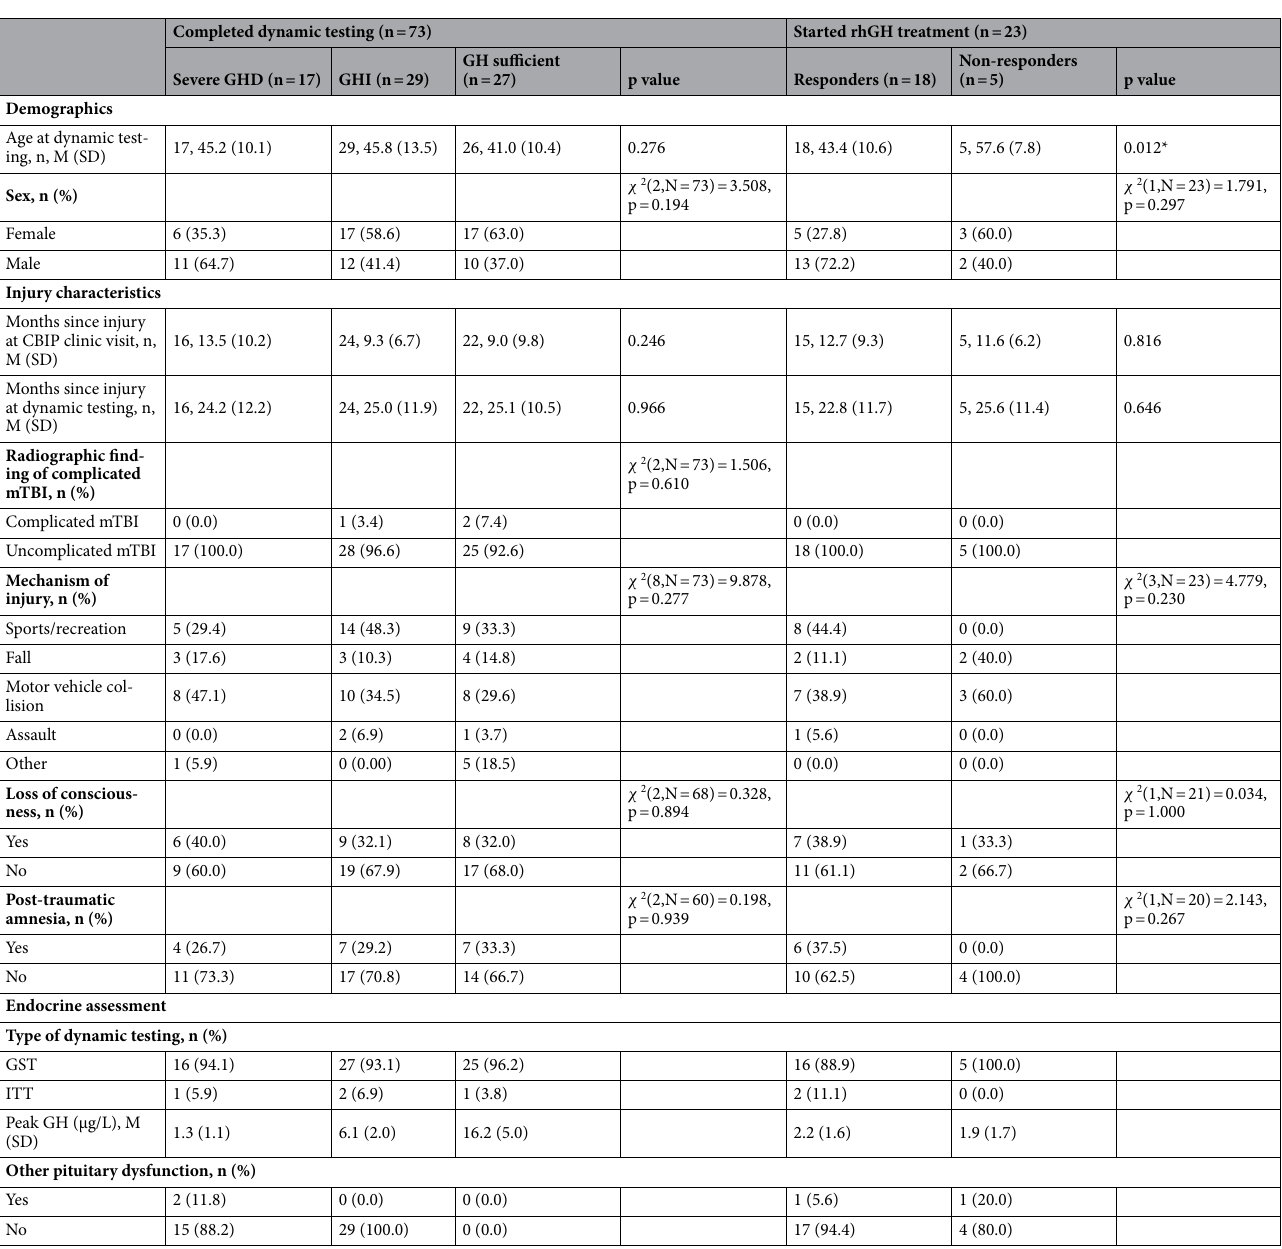
Table 2. Demographics, injury characteristics and endocrine assessment results according to dynamic testing results and treatment response. CBIP Calgary Brain Injury Program, GH growth hormone, GHD